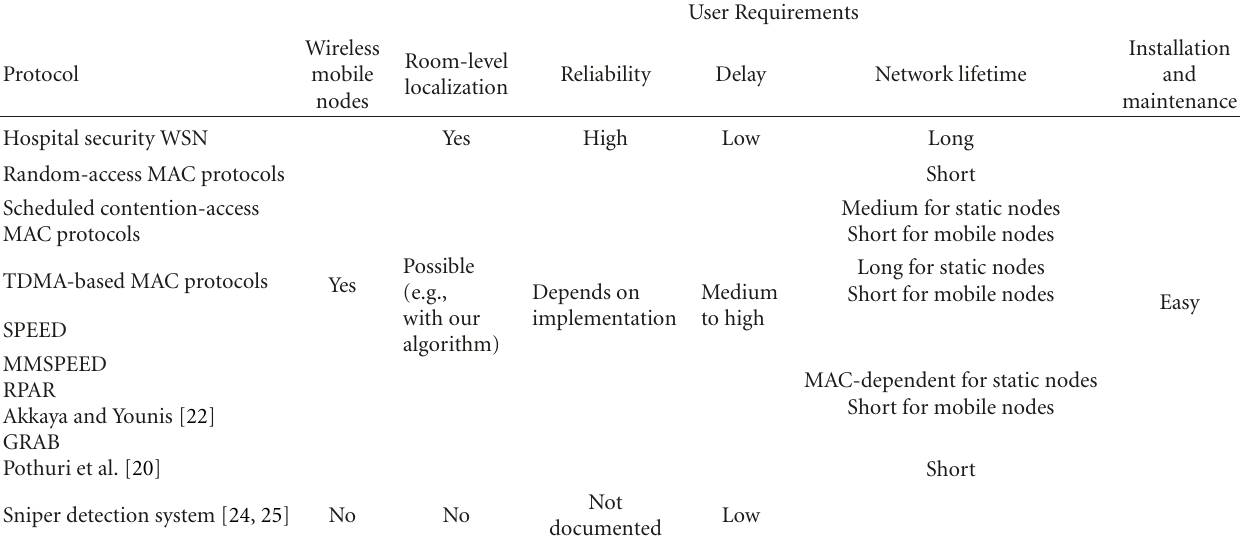
Table 2: Comparison of the hospital security WSN and related work against the user